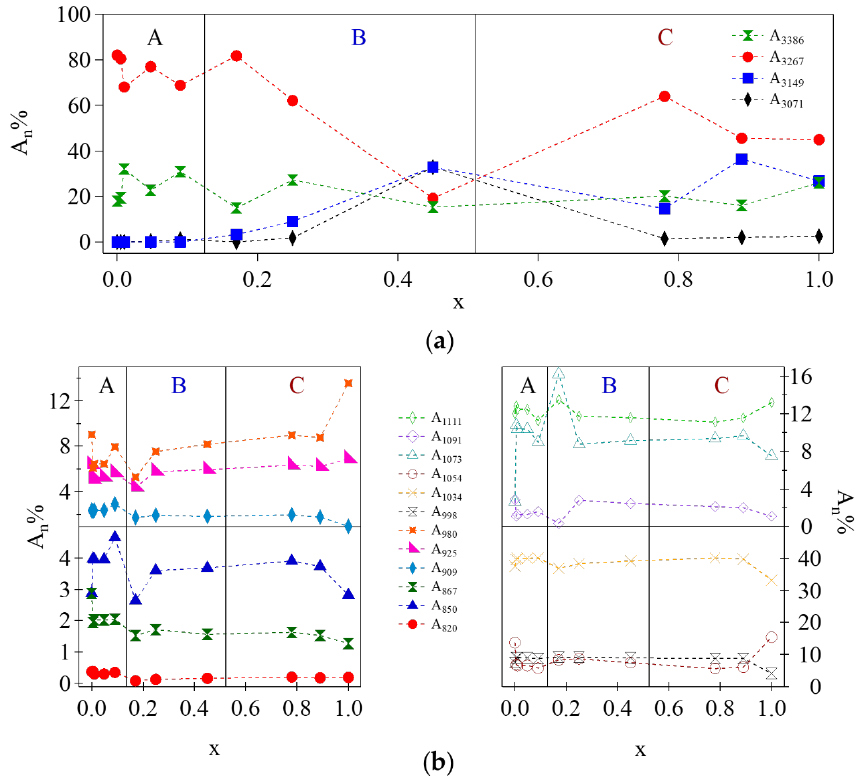
Figure 5. ( a ) Semiquantitative analysis of the peaks centered at ca. 3386, 3267, 3149, and 3071 cm −1 as a function of x; ( b ) Semiquantitative analysis of the peaks in the range 770–1150 cm −1 as a function of x.